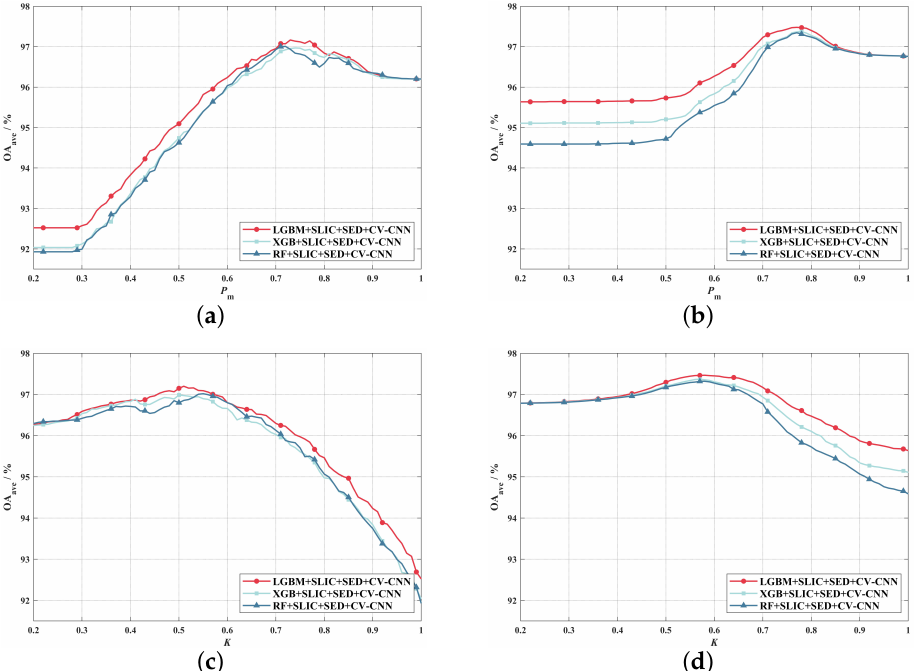
Figure 9. The average OA curve when LGBM, XGB and RF were used as the curves of the primary classifier. ( a ) OA ave - P m curve for Flevoland. ( b ) OA ave - P m curve for San Francisco. ( c ) OA ave - K curve for Flevoland. ( d ) OA ave - K curve for San